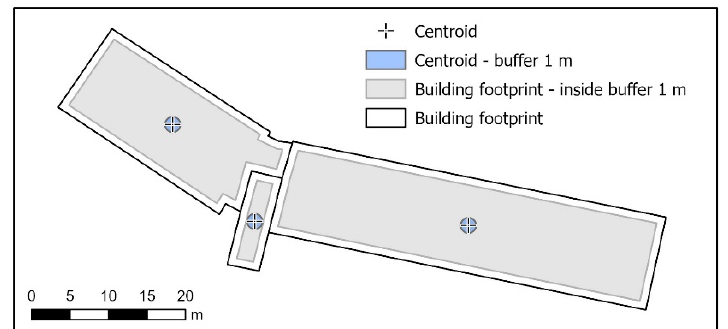
Figure 25. The centroid, the 1 m buffer around the centroid and the 1 m inside buffer for the footprint are visualized for a building.